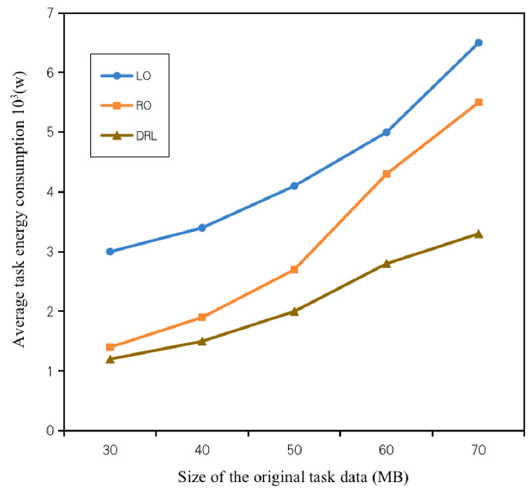
Figure 4. Diagram of energy consumption and data size.